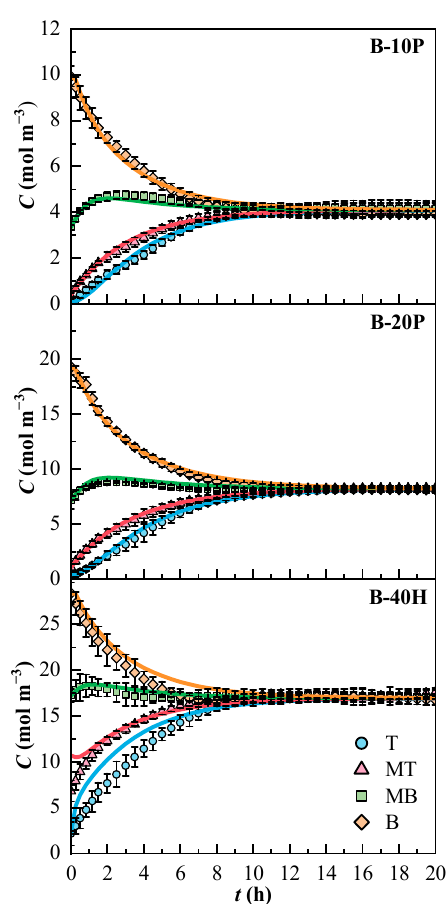
Figure 4. Experimental ( C exp , dots) and estimated ( C model , solid lines) concentration profiles of the binary mixtures over time. T (Top, ), MT (Medium Top, ), MB (Medium Bottom, ), and B (Bottom, ) correspond to the different heights of the measurement lines.